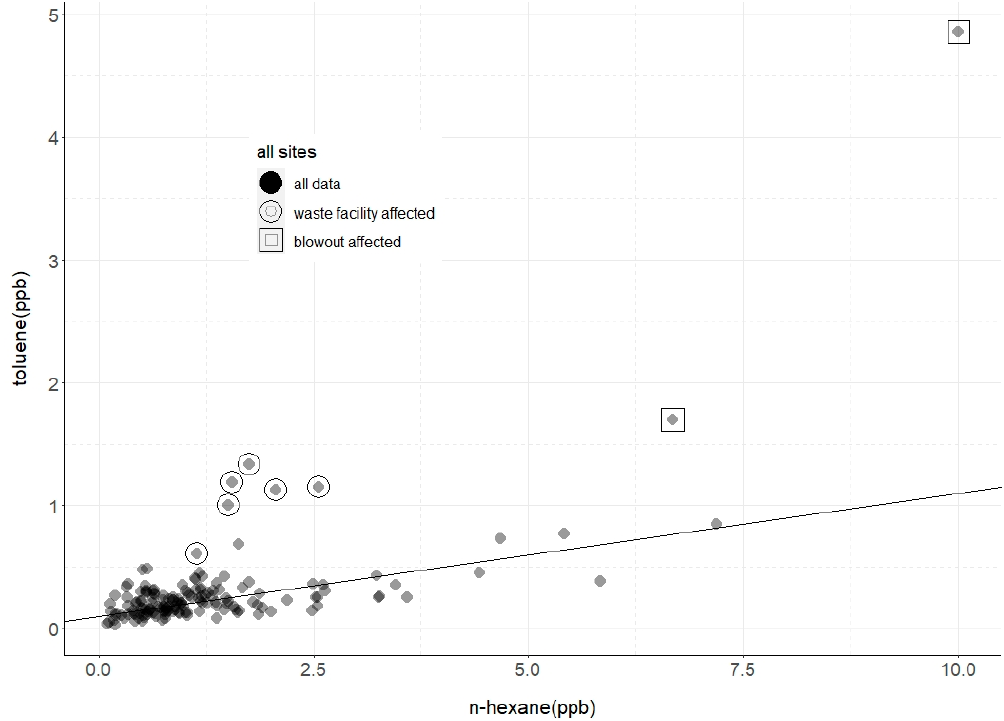
Figure 8. n-hexane vs. toluene scatterplot for the Nordheim sites. The tight correlation, illustrated by the solid regression line, was broken only during impacts from the nearby gas-well blowout (squared points) and impacts from oil waste deposited at the Hohn Rd. facility (circled points).